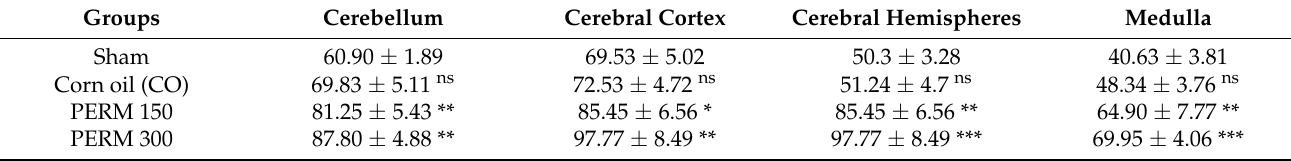
Table 2. Effect of permethrin exposure on lipoperoxidation of brain areas. MDA (nmoles /mL/mg of protein) levels in the different brain regions (cerebellum, cerebral cortex, cerebral hemispheres and medulla) of animals treated with permethrin (PERM 150 and 300 mg/kg) are shown as percentages (mean ± SD) of the levels detected in the vehicle and sham groups. Groups Cerebellum Cerebral Cortex Cerebral Hemispheres Medulla Sham 60.90 ± 1.89 69.53 ± 5.02 50.3 ± 3.28 40.63 ± 3.81 Corn oil (CO) 69.83 ± 5.11 ns 72.53 ± 4.72 ns 48.34 ± 3.76 ns PERM 150 PERM 300 87.80 ± 4.88 ** 69.95 ± 4.06